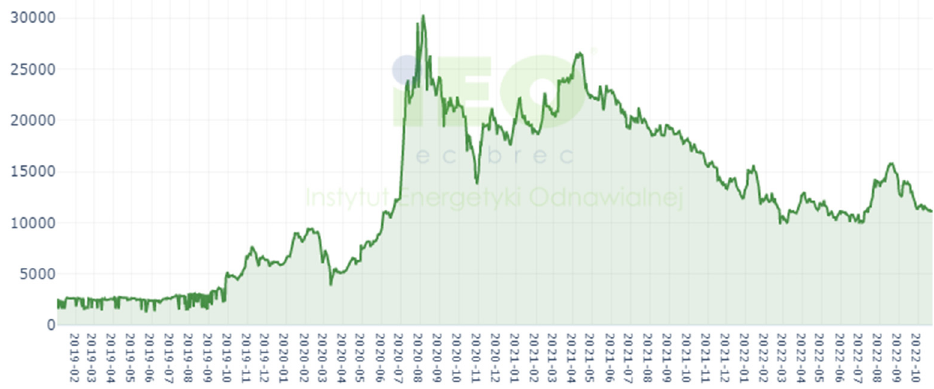
Figure 5. Institute for Renewable Energy Photovoltaic Index: four-year quotes. Source: [80].